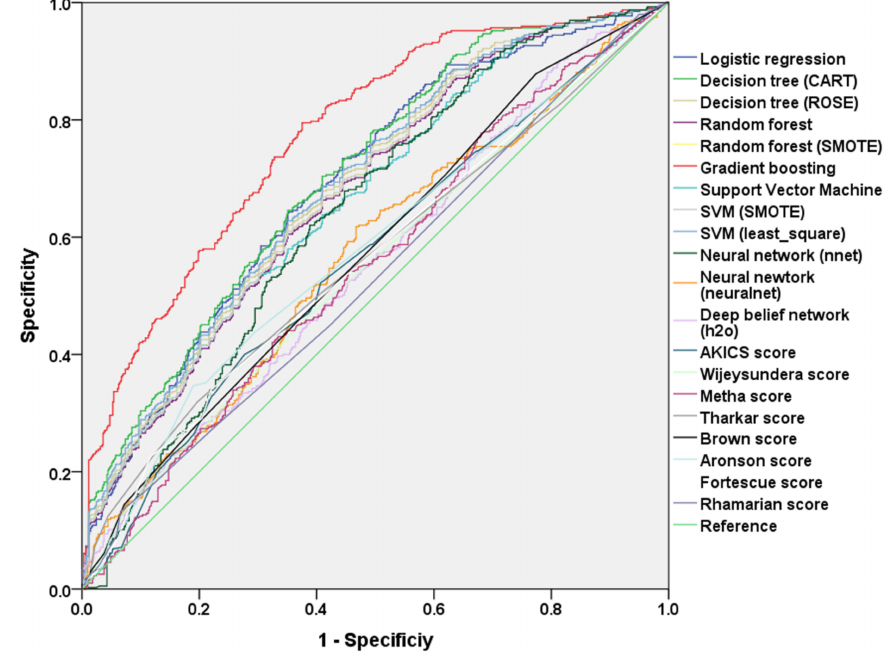
Figure 1. Comparison of AUC among the different machine learning models and logistic regression model. AKICS = acute kidney injury after cardiac